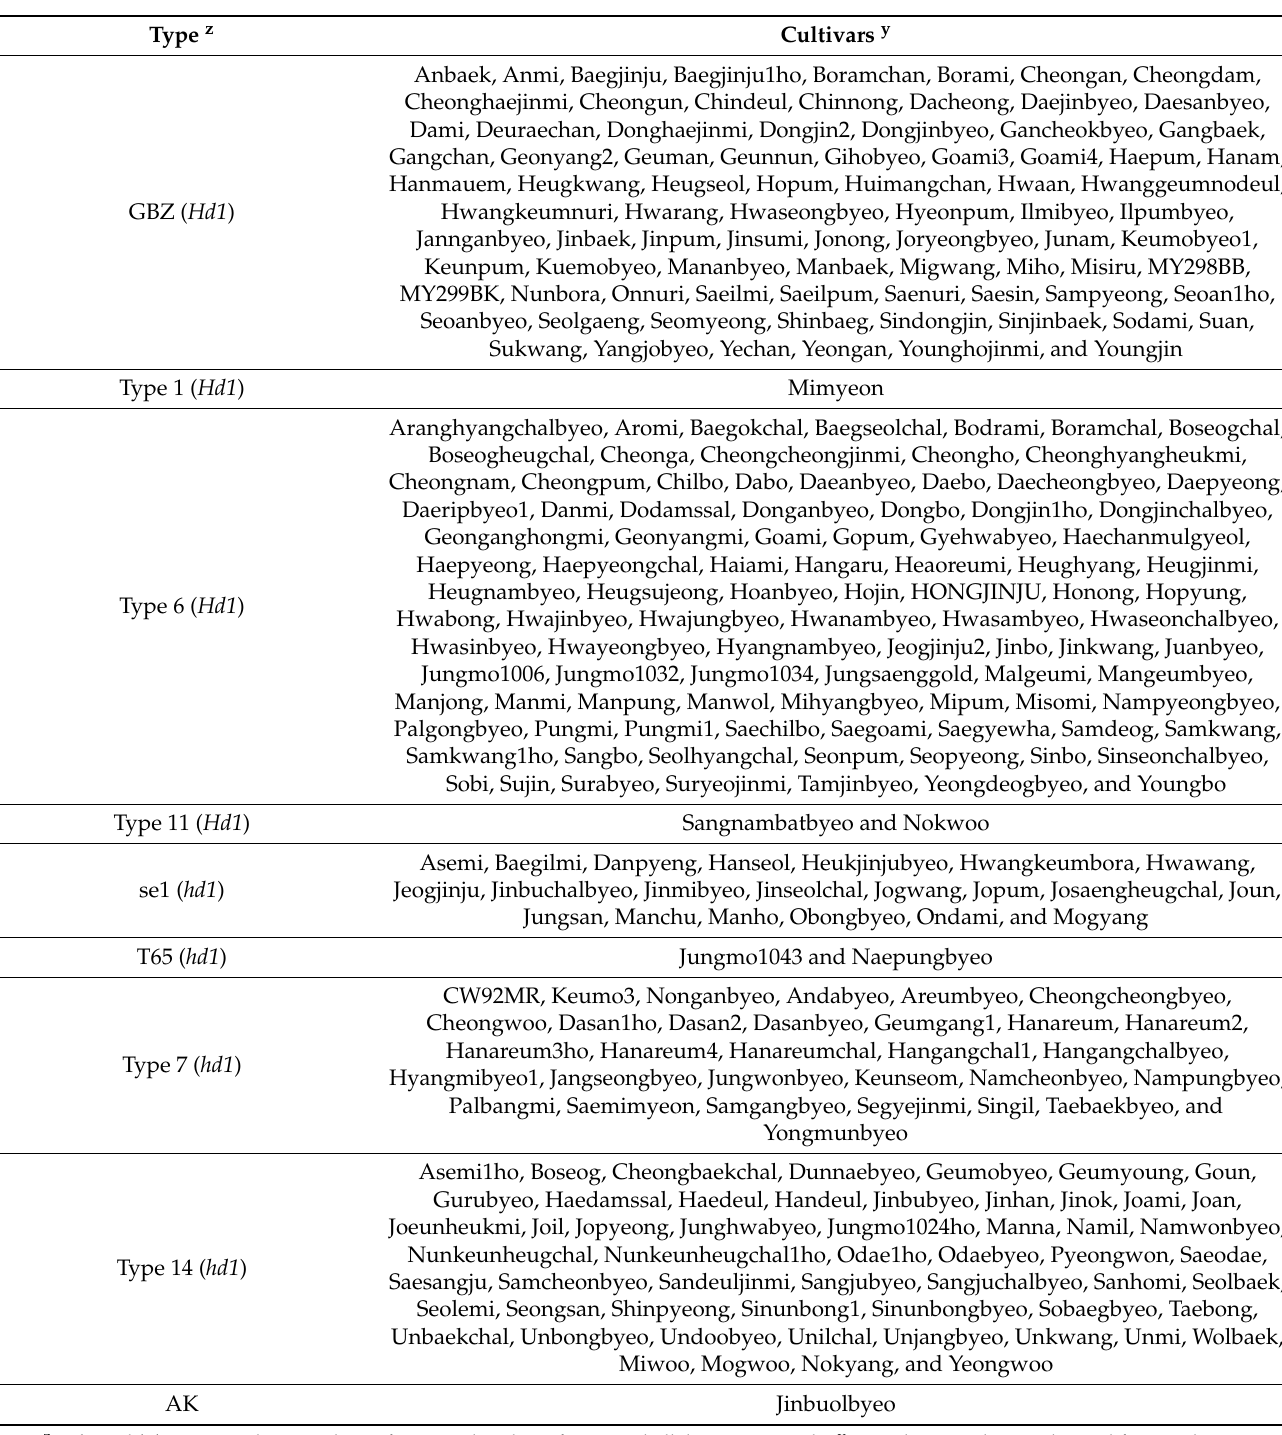
Table 1. Hd1 allele types of 293 Korean rice